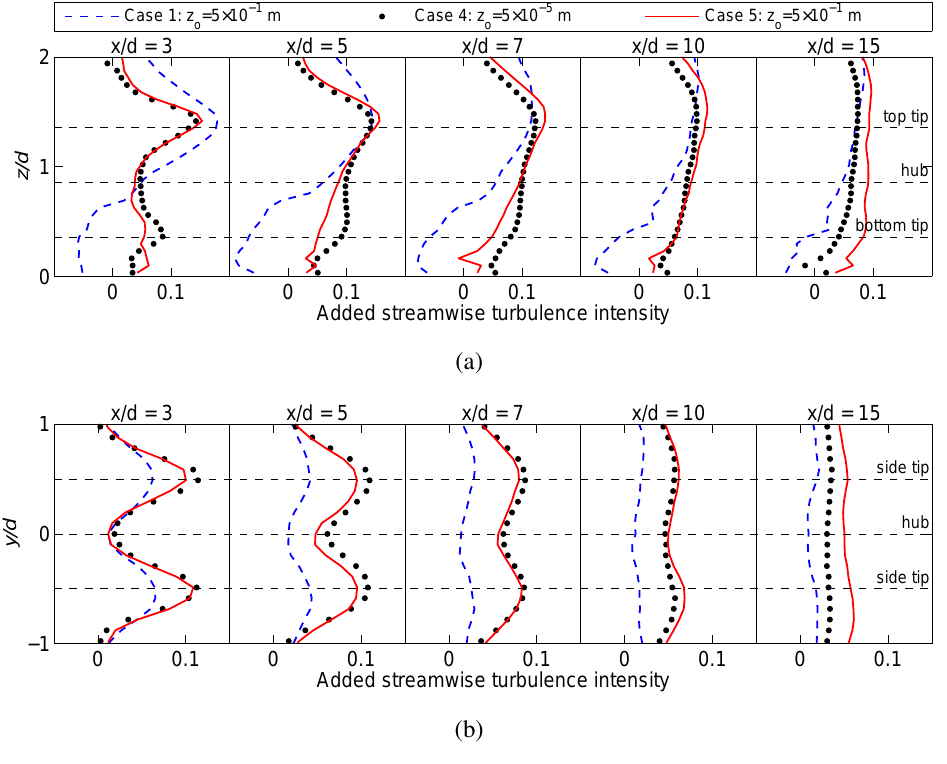
Figure 13. Comparison of vertical ( a ) and lateral ( b ) profiles of the added streamwise turbulence intensity I through the centerline of the u,add